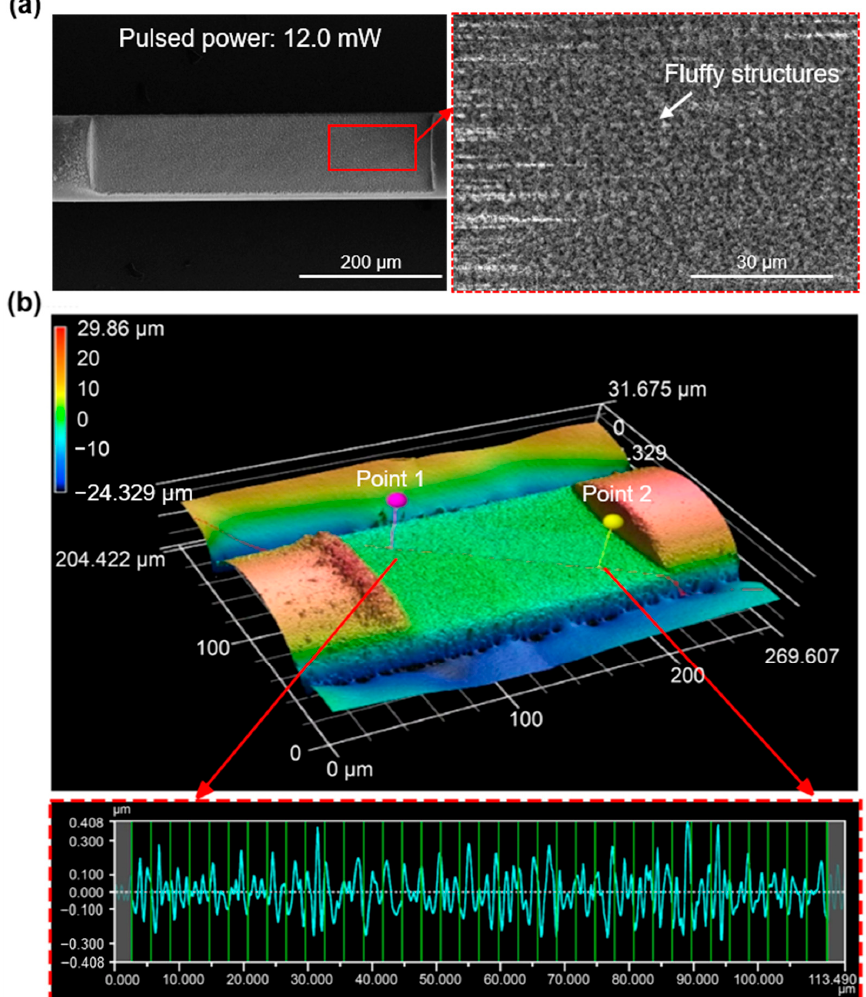
Figure 5. ( a ) SEM image and ( b ) 3D view of the polished area of the side-polished SMS fiber under a pulsed power of 12.0 mW corresponding to L = 500 μ m and L = 200 μ m, respectively.